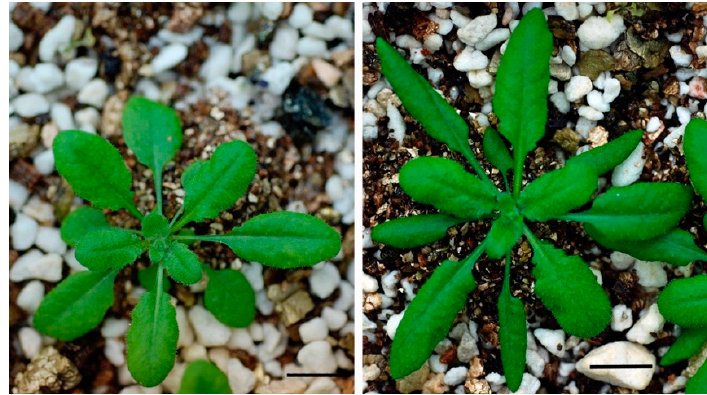
Figure 1. Typical 4-week-old plants of Arabidopsis thaliana accession Columbia grown in the presence (right) or absence (left) of 50 ppb nitrogen dioxide (NO 2 ). Bar = 1 cm.